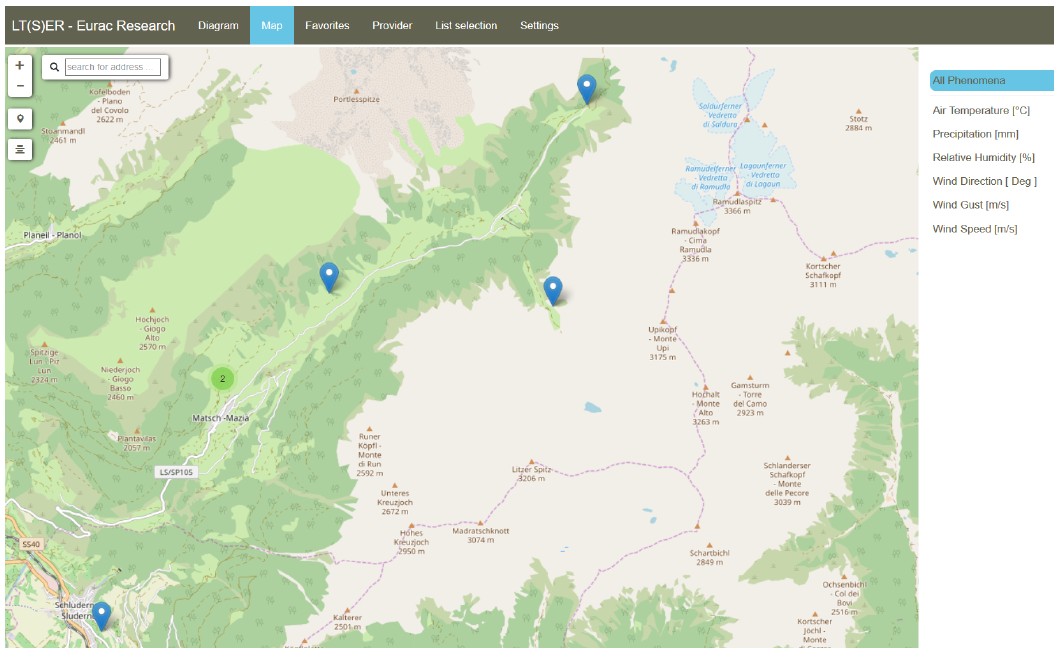
Figure 11. Public LT(S)ER web application, view of the Map